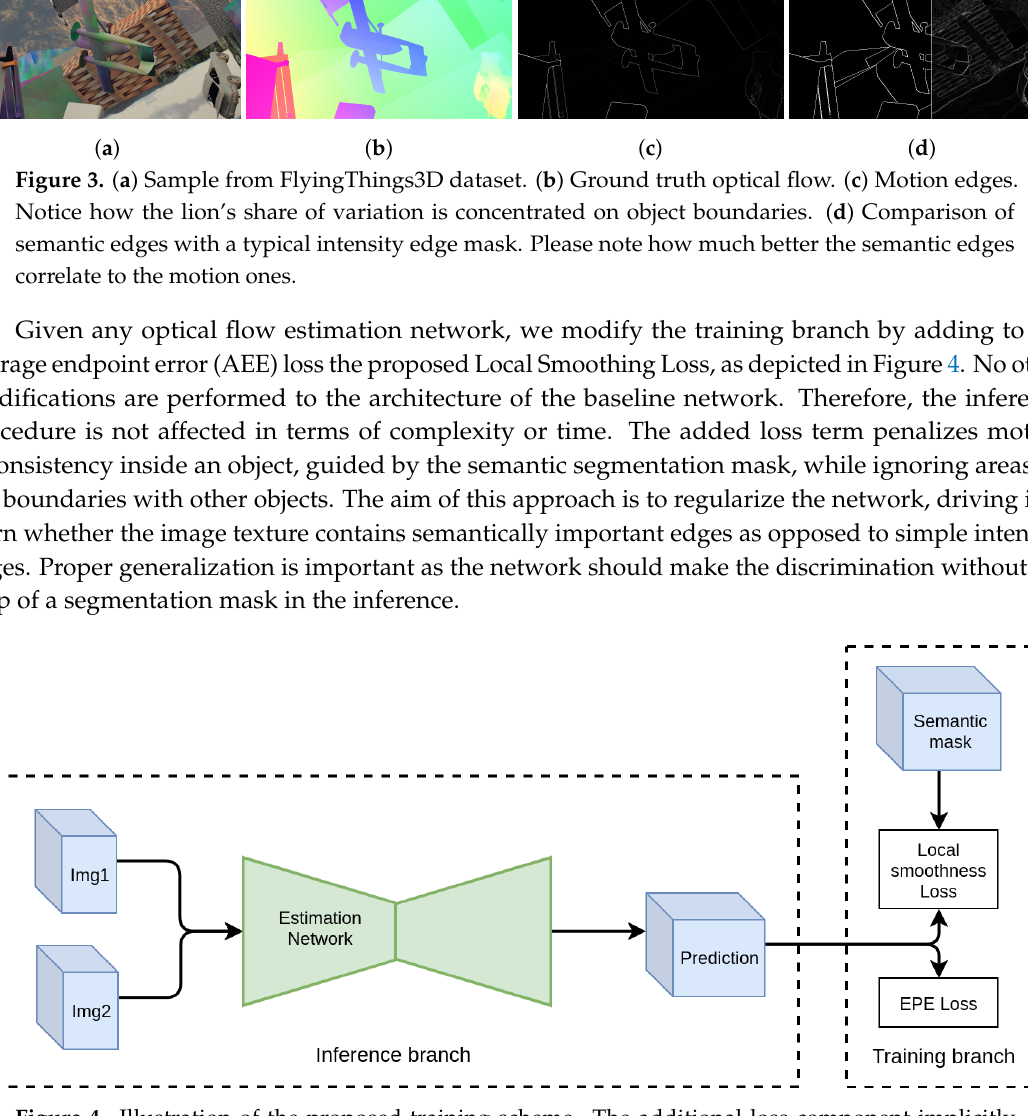
Figure 4. Illustration of the proposed training scheme. The additional loss component implicitly regularizes the predictions during training time, requiring no modifications at